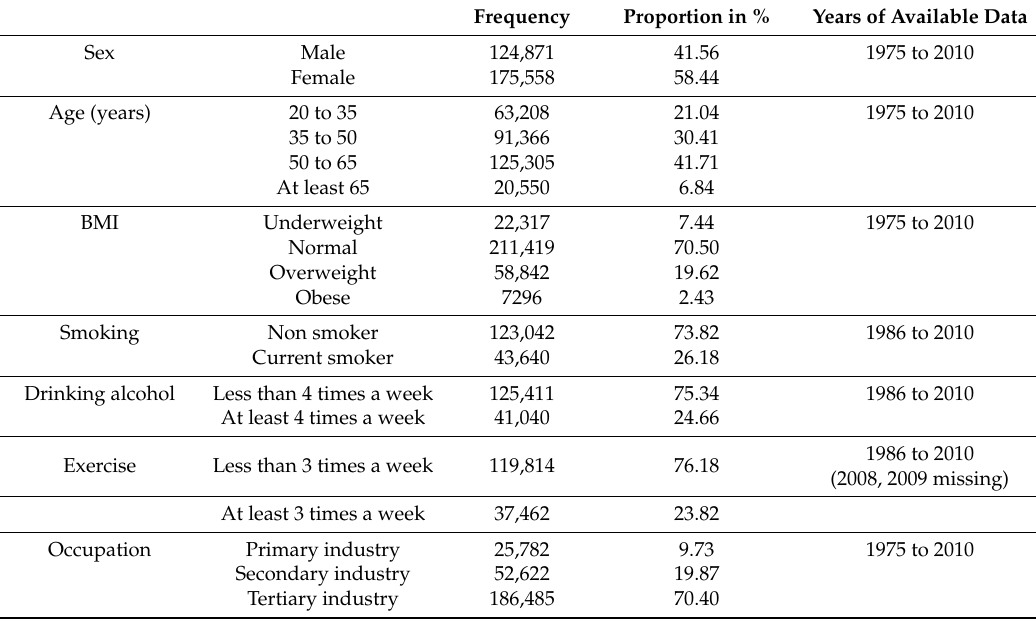
Table 1. The characteristics of the sample.